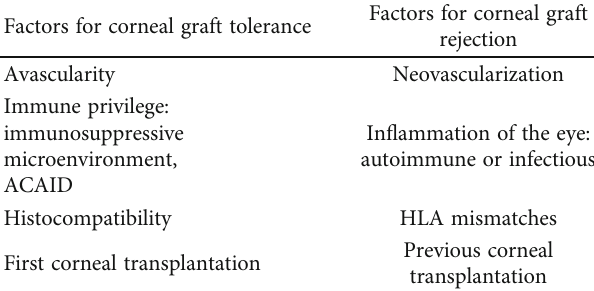
Table 2: Factors in fl uencing corneal graft acceptance and rejection. ACAID: anterior chamber-associated immune deviation; HLA: human leukocyte